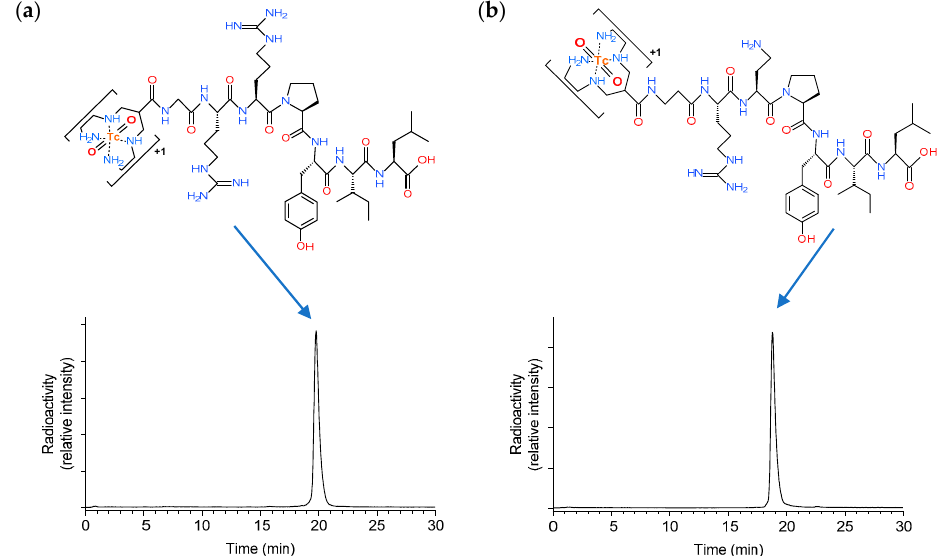
Figure 1. Representative radiochromatograms of high-performance liquid chromatography (HPLC) analysis of the radiolabeling mixture of ( a ) [ 99m Tc]Tc–DT1 and ( b ) [ 99m Tc]Tc–DT5 with the respective radioligand structures indicated.